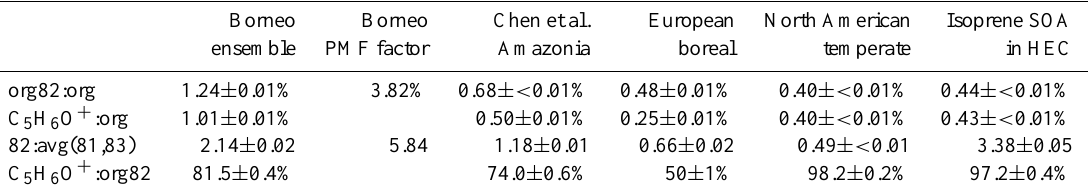
Table 1. Comparison of % of organic aerosol signal measured at m/z 82 and at C 5 H 6 O + , the ratio of organic m/z 82 to the mean adjacent organic peak heights, and the % of the organic m/z 82 peak that is C 5 H 6 O + , at different locations across the World, and in isoprene oxidation experiments (isoprene:NO x > 200 : 1 ) in the Harvard Environmental Chamber. Standard errors calculated from propagation of standard deviations of time series are shown (where appropriate). The Borneo data points are from the OP3 project as reported in this paper. The Amazonia data are from the AMAZE campaign as reported by Chen et al. (2009), in-basin classification. The boreal European data were collected as part of the EUCAARI campaign (Kulmala et al., 2009). The North American temparate data (see Appendix A) were taken as part of the BEARPEX campaign. Borneo Borneo Chen et al. European North American Isoprene SOA ensemble PMF factor Amazonia boreal temperate in